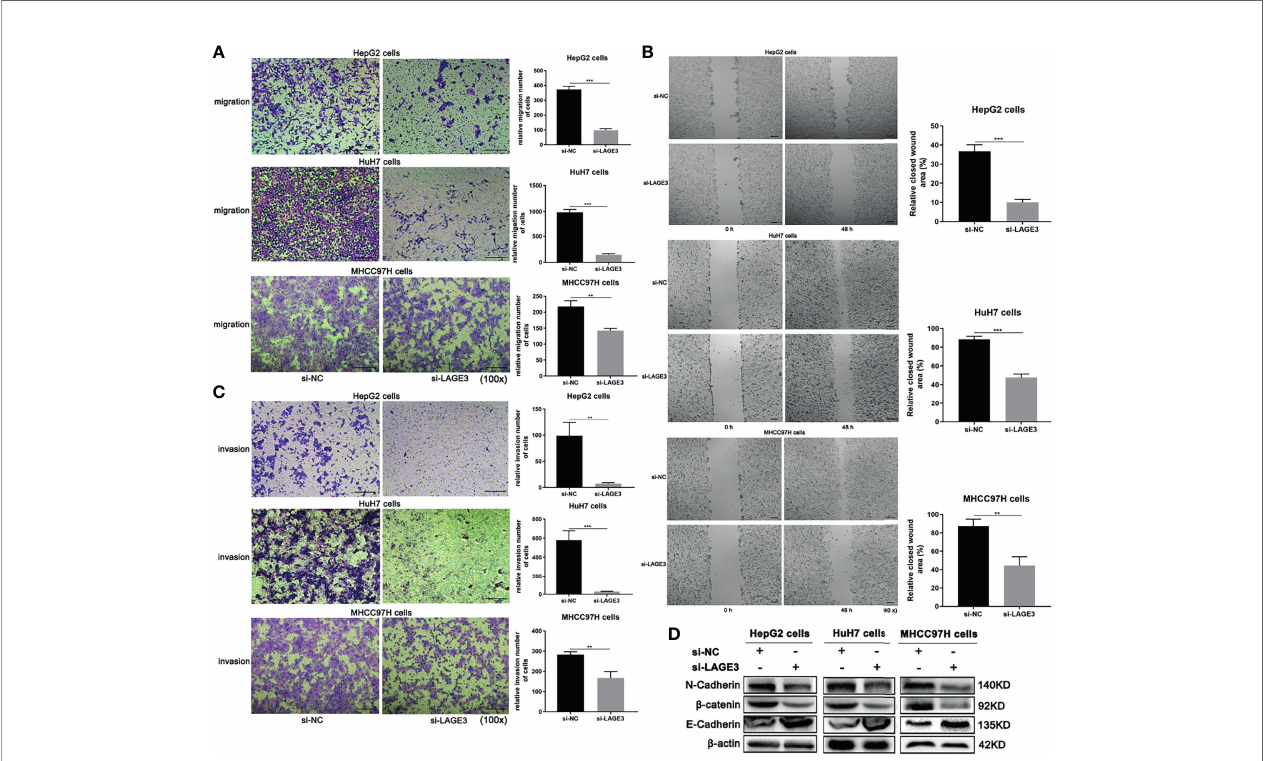
FIGURE 9 | Down-regulation of LAGE3 suppresses migration and invasion of HCC cell lines. (A, B) Transwell assays (A) and wound-healing assays (B) showing the migration of HepG2, HuH-7, and MHCC97H cells transfected with si-LAGE3 or si-NC, respectively. (C) The invasion abilities of HepG2, HuH-7, and MHCC97H cells transfected with si-LAGE3 or si-NC. (D) Changes in protein expression of E-cadherin, N-cadherin, and b -catenin in HepG2, HuH-7, and MHCC97H cells transfected with si-LAGE3 or si-NC. All experiments were conducted in triplicate. Data are expressed as mean ± standard deviation (SD). ** P < 0.01 and *** P < 0.001 compared with si-NC